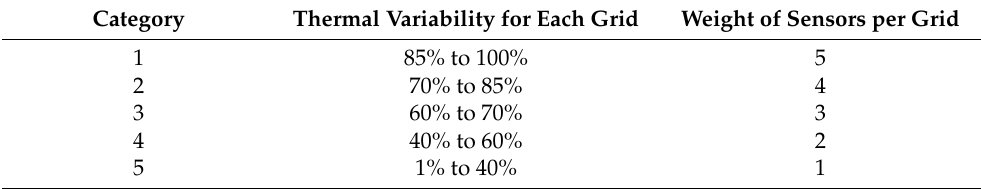
Table 3. Criteria for category assignment to the